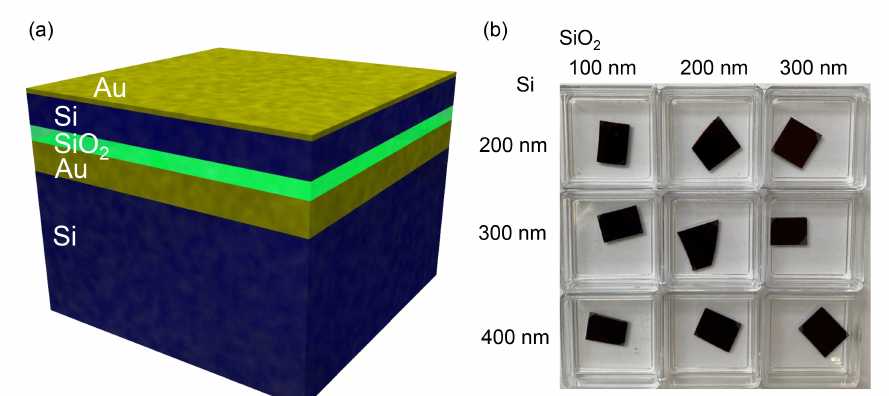
Figure 1. ( a ) Schematic illustration of fabricated multi-layer black metals. ( b ) Photographs of the black metal samples with different semiconductor and dielectric layers.